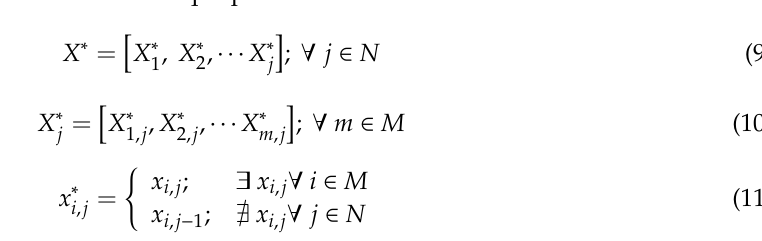
Figure 3. Estimated missing data values.